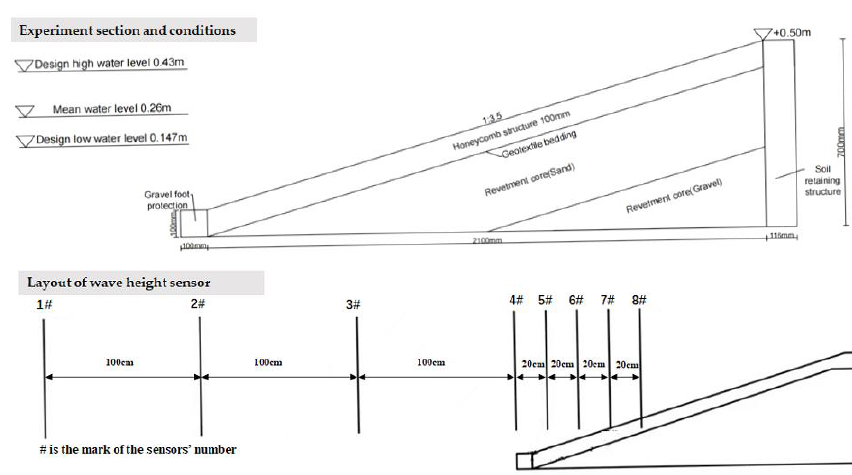
Figure 2. Schematic diagram of the experimental section.